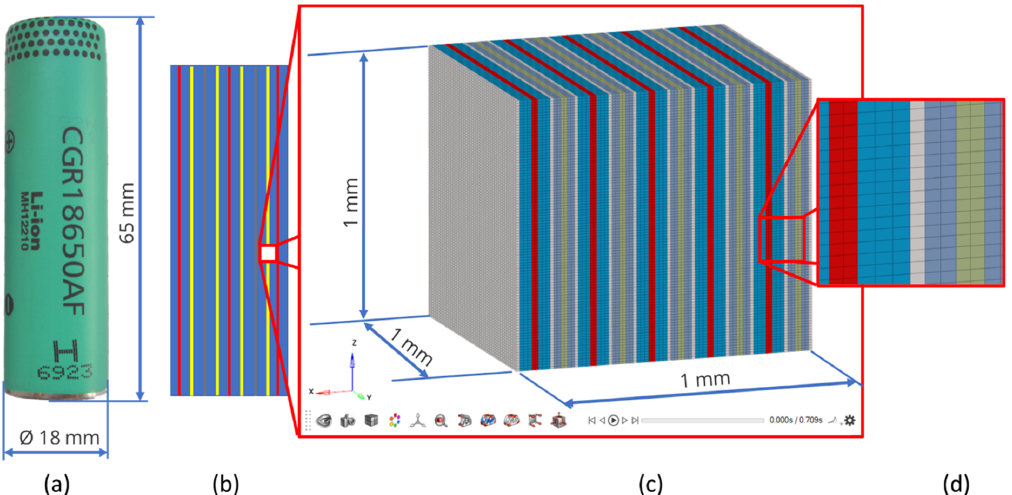
Figure 1. Panasonic CGR18650AF Li-Ion cell: ( a ) real photo and ( b ) schematic cut-view, ( c ) Finite-Element-mesh using an 1 × 1 × 1 mm representative volume, ( d ) detailed view of the 3d hexahedron elements with an average element size of 0.01 × 0.01 × 0.01 mm showing the separator layer in white.